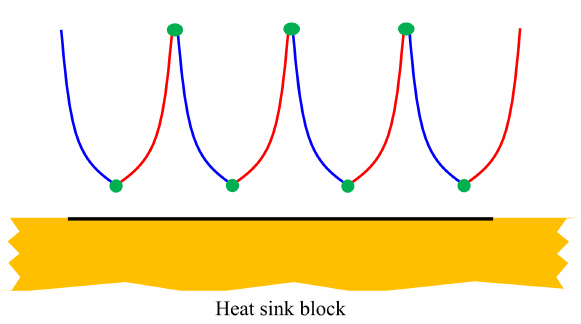
Figure 6. Thermopile consisting of 4 thermocouples—application on a copper